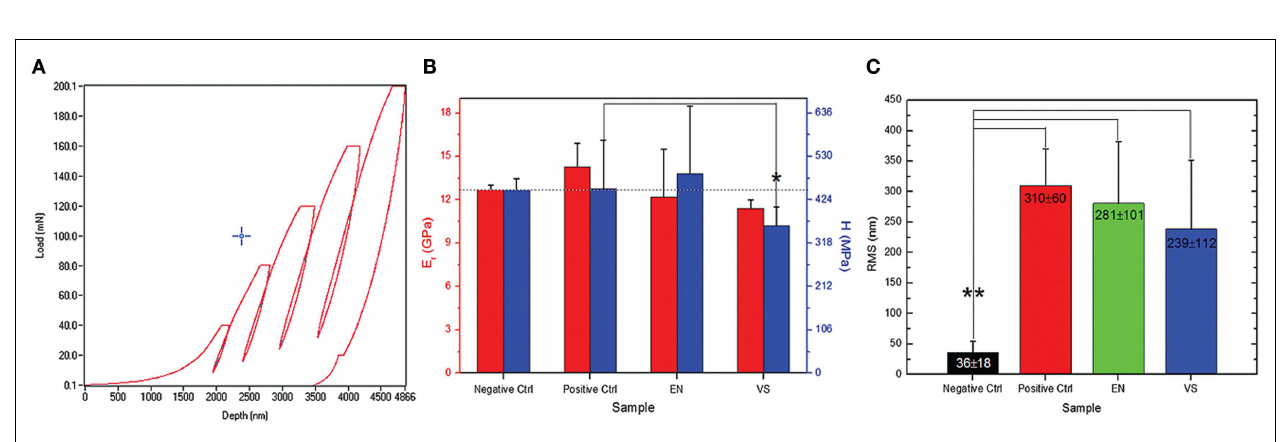
here), values of hardness H and elastic modulus E can be obtained. (C) RMS roughness values resulting from AFM images of the polished restorative material. Reprinted from Salerno et al.